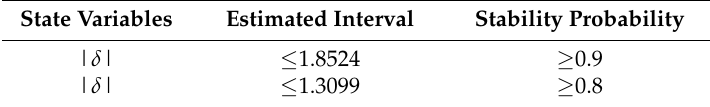
Table 1. Theoretical results with SMIB. SMIB: single-machine infinite-bus. State Variables Estimated